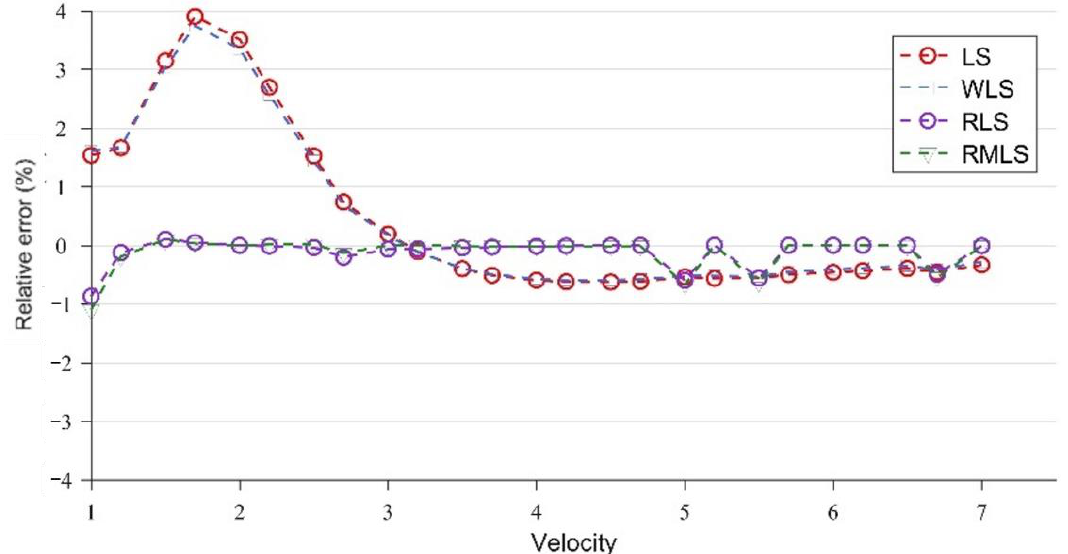
Figure 10. Results of LS, WLS, RLS, and RMLS with noise at x = 300 cm.